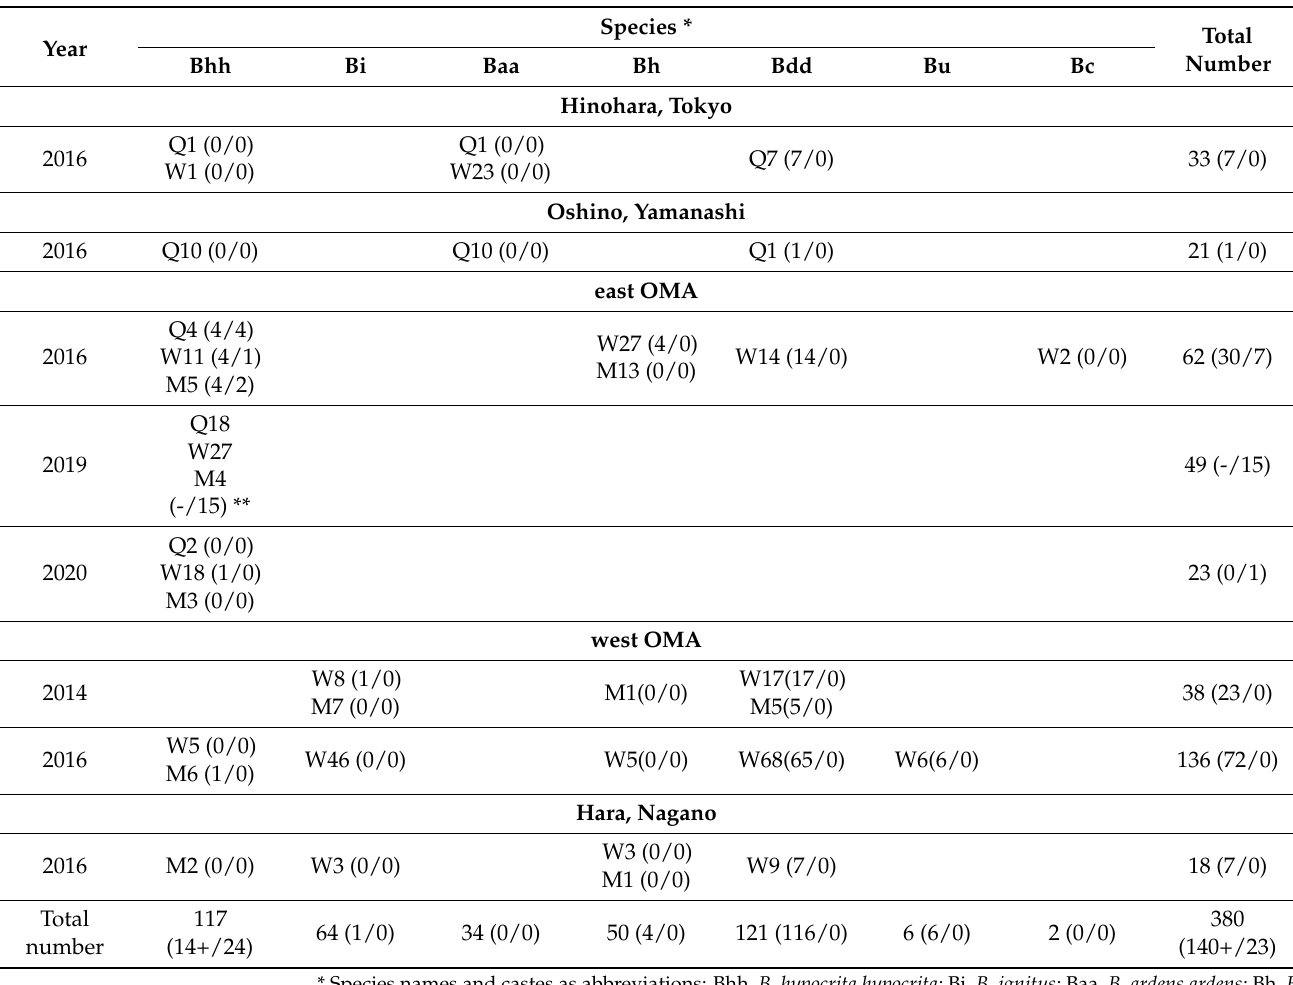
Table 2. List of bumblebee species collected in Honshu and results of the PCR amplification of small subunit (SSU) rRNA and